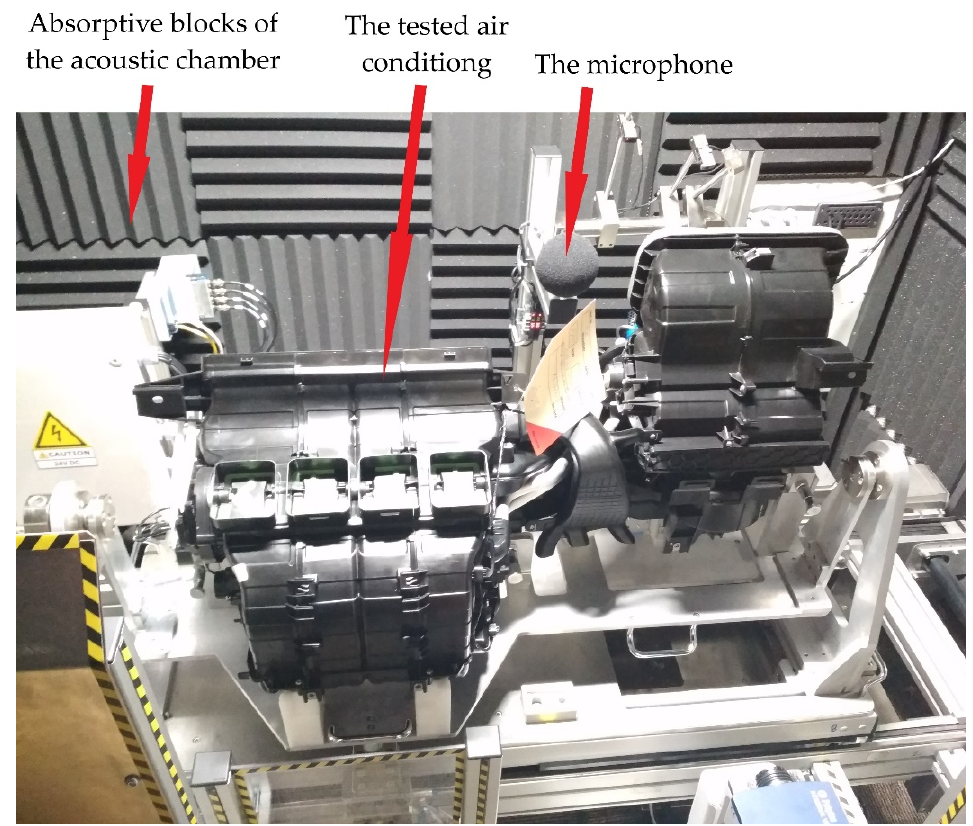
Figure 1. Testing of the heat, ventilation, and air-conditioning device (HVAC) inside the anechoic chamber, situated in the manufacturing plant of ELCOM, a.s.